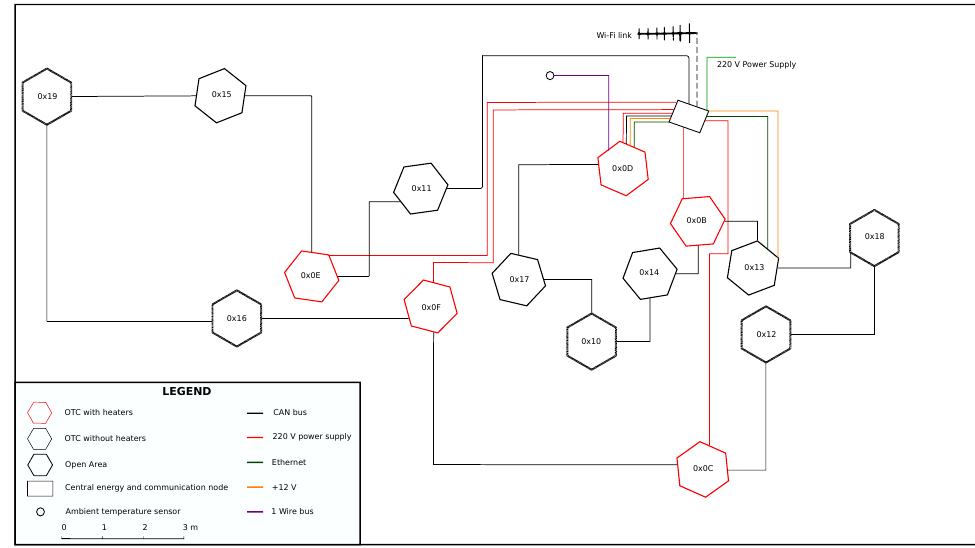
Figure 5. A schematic view of the measurement setup installed in